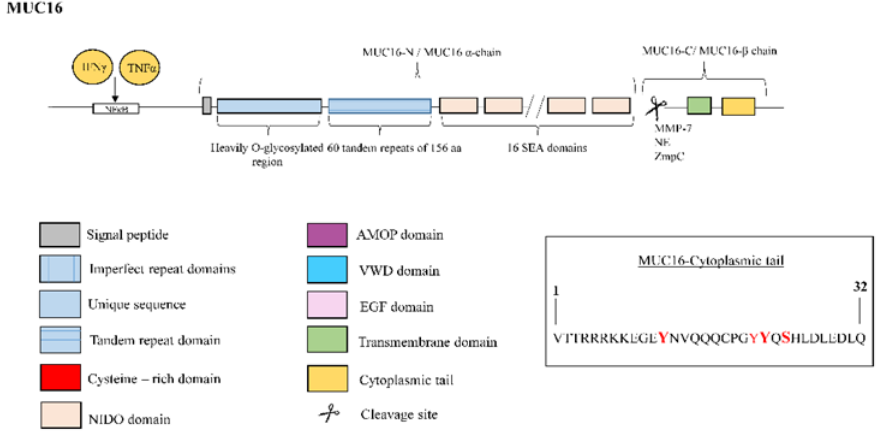
Figure 11. Structure of mucin MUC16. MUC16 protein is comprised by two subunits, the MUC16-N terminal or α subunit and the MUC16-C terminal or β subunit. The N-terminal subunit is constituted by a typical, heavily O-glycosylated mucin domain, 60 tandem repeats of 156 amino acids and 16 SEA modules. Otherwise, the C-terminal portion consists of a transmembrane (TM) region and a 32-residue cytoplasmic tail. The right box contains the amino acid sequence of the cytoplasmic tail with potential sites for phosphorylation marked in red color. For the amino acids in bold red font, phosphorylation was demonstrated. MUC16 clevage occurs in the 12 extracellular amino acids domain proximal to the TM domain. Proteases such as metalloproteinase-7 (MMP-7), neutrophil elastase (NE) and bacterial metalloprotease (ZmpC) have been implicated in enhanced shedding of MUC16 from the cell surface. Tumour necrosis factor (TNF)- α and interferon (IFN)- γ stimulate the expression of MUC16 through an nuclear factor kappa B (NF- κ B) response element in the MUC16 promoter.